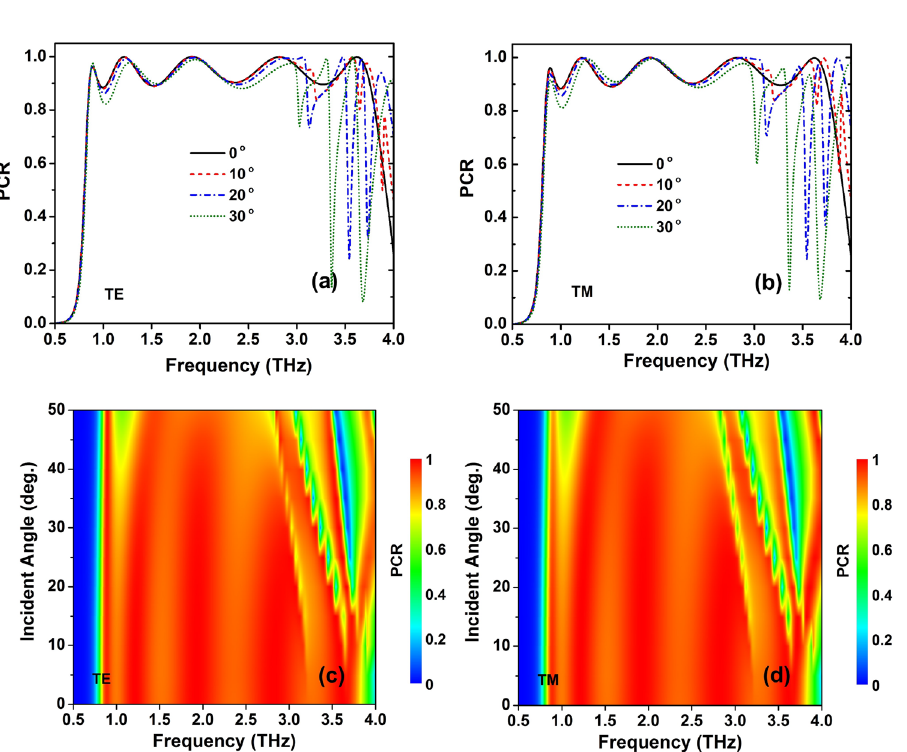
Figure 13. Dependence of PCR on incident angle of the proposed RMS for PC mode: ( a, c ) TE mode and ( s, d ) TM mode. In ( a and b ) plot the PCR spectra at the selected incident